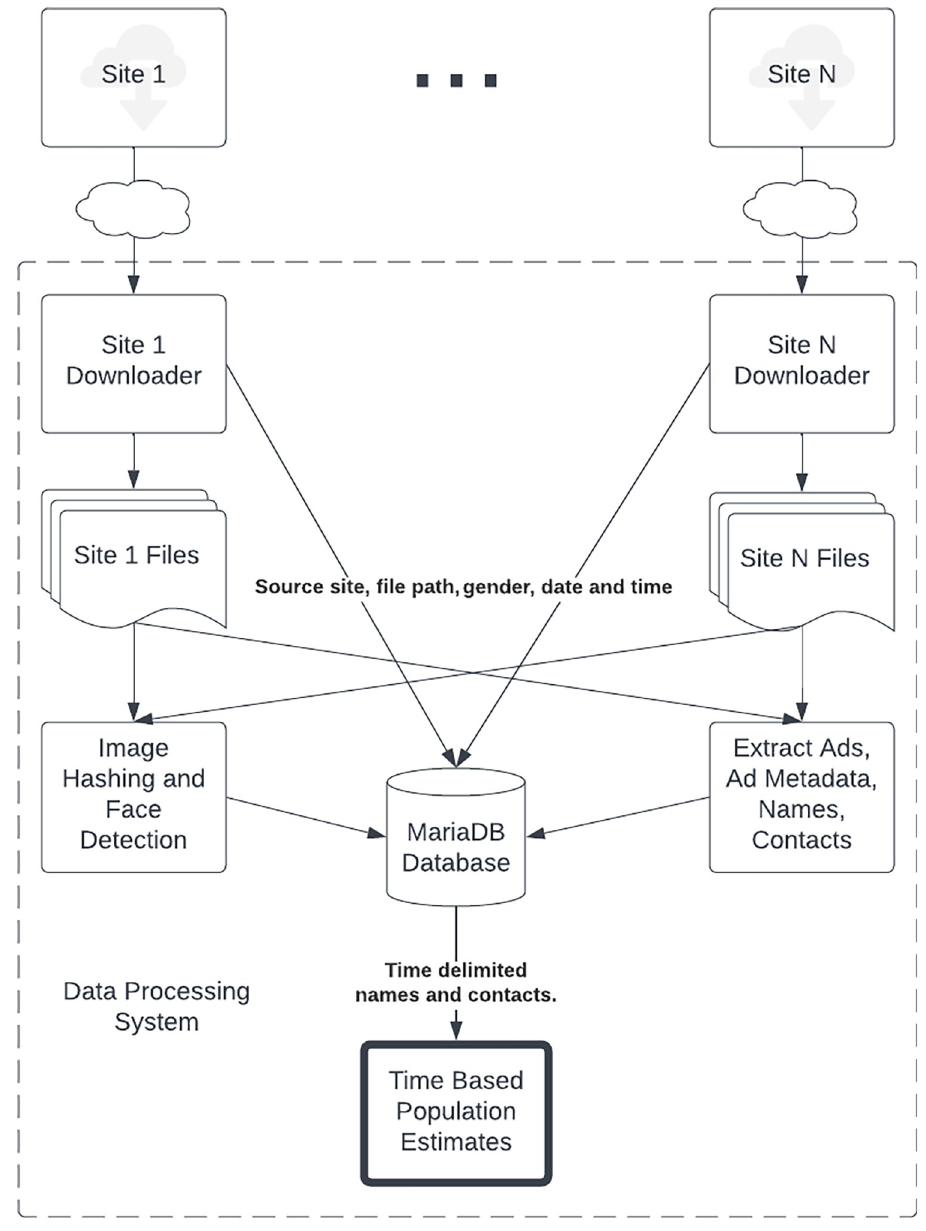
Fig 1. Flow diagram illustrating the data processing pipeline used to generate population